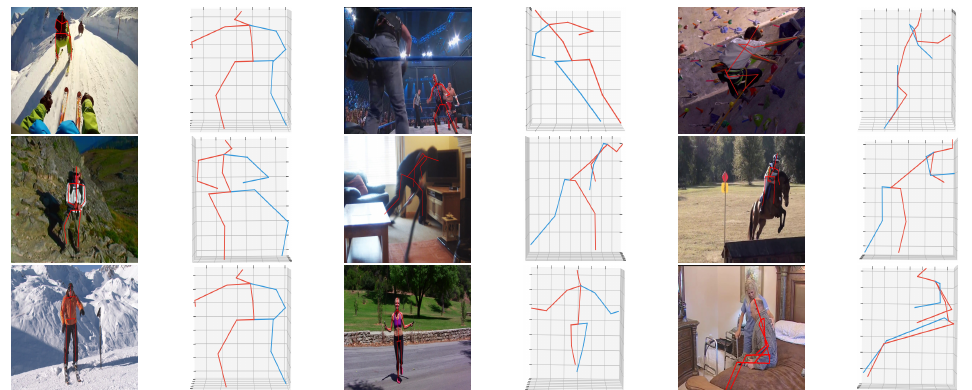
Figure 5. Qualitative results on the MPII dataset. Columns 1, 3, and 5 are the input images and columns 2, 4, and 6 are corresponding 3D poses generated by our